Question: What does this figure show? Answer in one sentence.
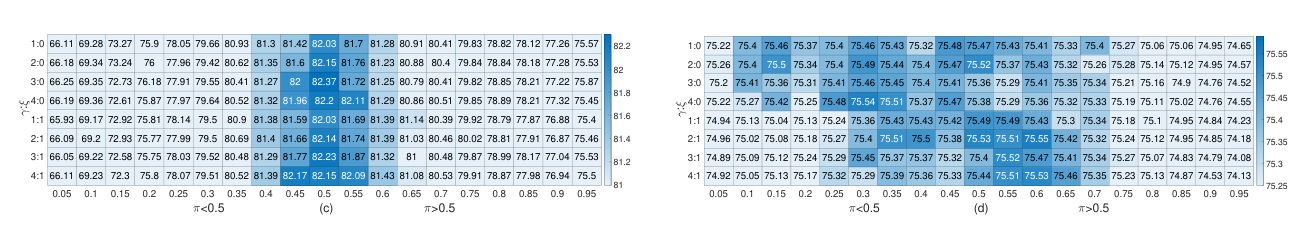
Answer: Test accuracy(%) patterns of 20 × 20 SIC models for (a) two-class and (b) multi-class. Test accuracy(%) patterns of 19 × 8 convex focal losses for (c) two-class and (d) multi-class. As shown in (a), SIC models exhibit an X-shaped pattern, i.e., | α−−1 | ≈| α+ −1 |. This indicates that the best-performing SIC models have similar polynomial order between LS α+,c+ and LS α−,c−. This X-shaped pattern covers a much larger region than the π- weighted convex focal losses in (c). For more information and statistical distribution of the models, refer to Figure 6.